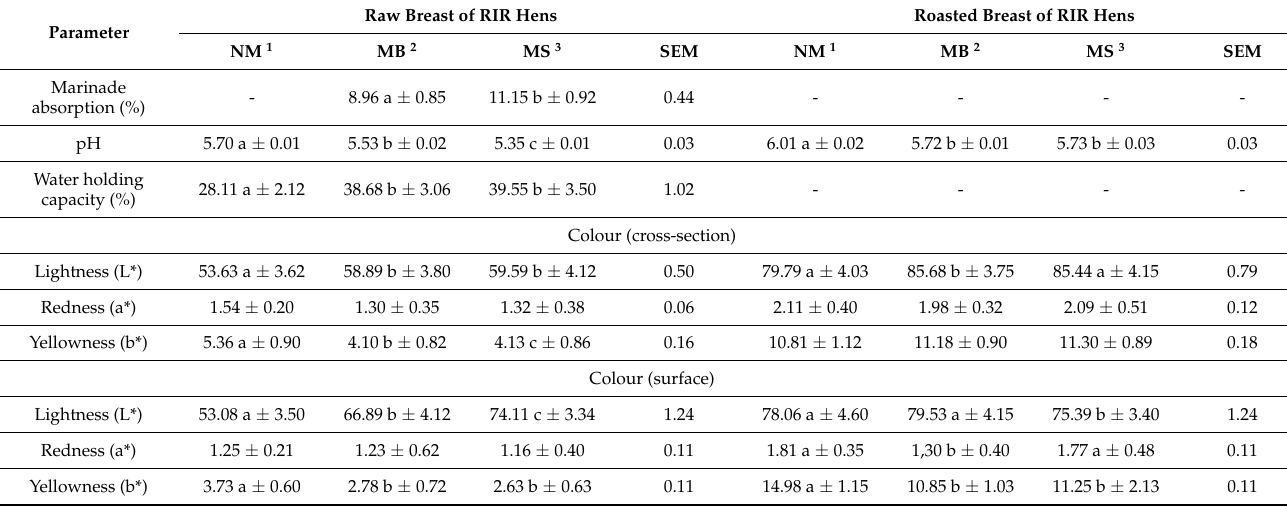
Table 1. Effect of marinating with fermented milk products on the physical characteristics of raw and roasted hen breast meat. Raw Breast of RIR Hens Roasted Breast of RIR Parameter